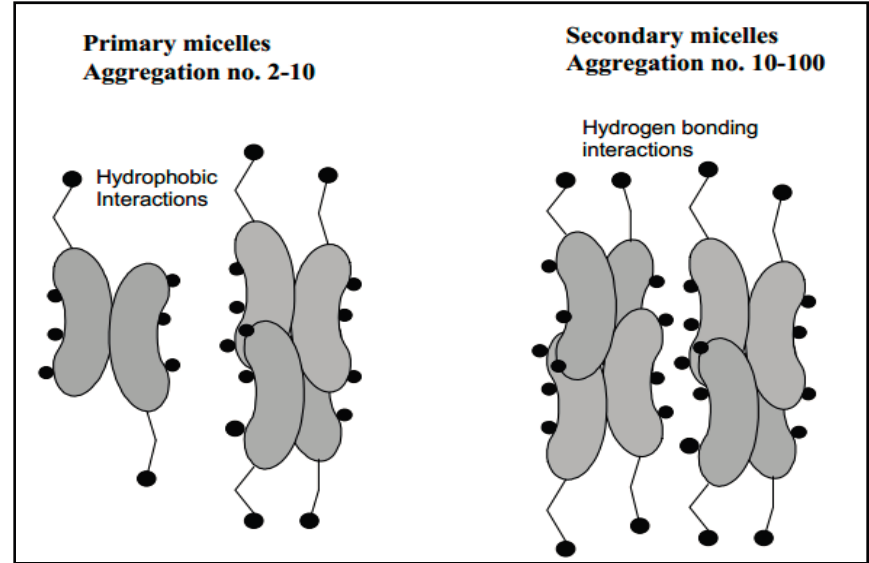
Figure 2. Primary and secondary aggregation model of bile salt micelles